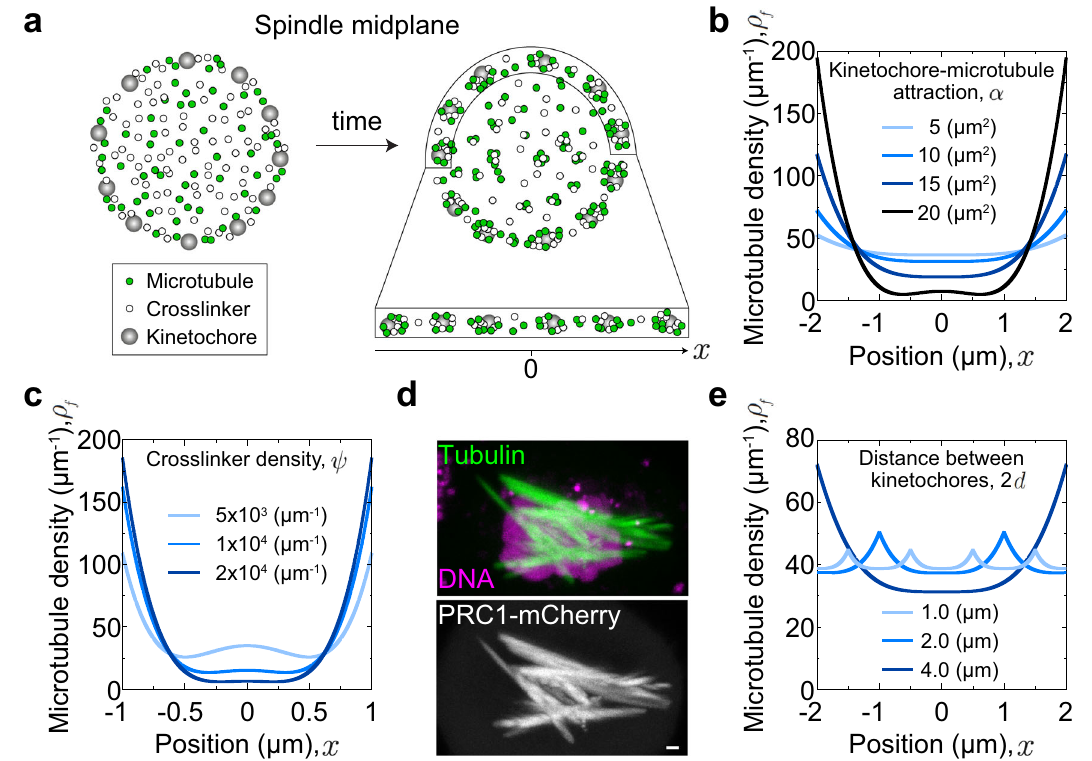
Fig.5|Theoreticalmodelofbundleformation.a Schematicrepresentationofthe model. Kinetochores (gray) are equally spaced along the edge of the spindle mid- plane. Microtubules (green) and crosslinkers (white) are initially uniformly dis- tributed andgatherintobundlesovertime. b Steady-state microtubuledensity, ρ f , for 4 values of the kinetochore-microtubule attraction, α , as indicated. Other parameters are: ψ = 10000 μ m (cid:1) 1 , d = 2 μ m , κ = 10 μ m 3 , w = 1 μ m 3 . The kine- tochores are positioned at x = ± d . c Steady-state microtubule density, ρ f , for 3 values of the crosslinker density, ψ , as indicated; α = 20 μ m 2 , d = 1 μ m , κ = 5 μ m 3 ,